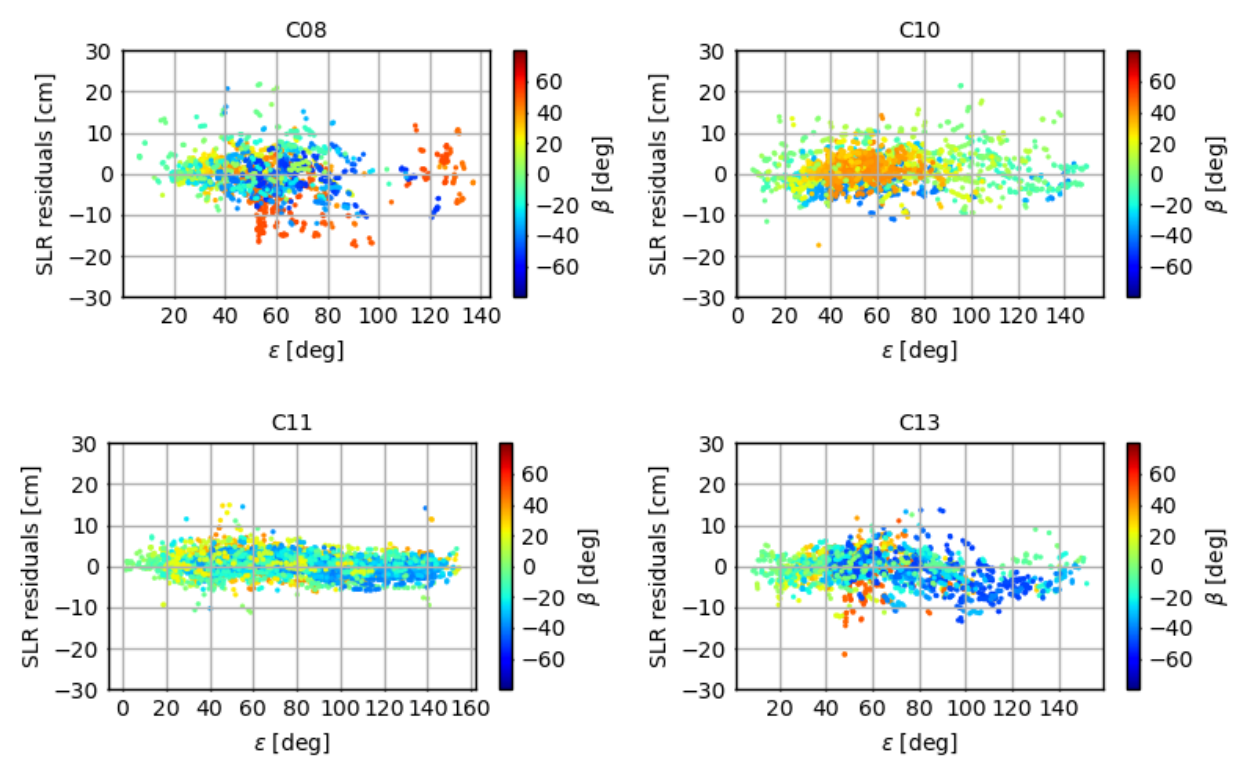
Figure 10. The histograms of the SLR residuals of the four solutions for the four BDS-2 IGSO and MEO satellites tracked by ILRS. All values are in cm.